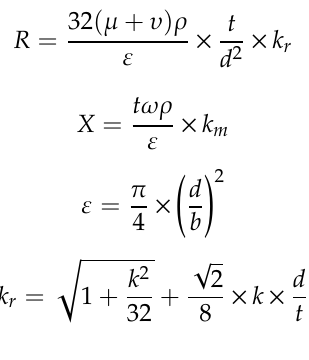
Figure 8. Schematic diagram of the composite sound-absorbing structure.